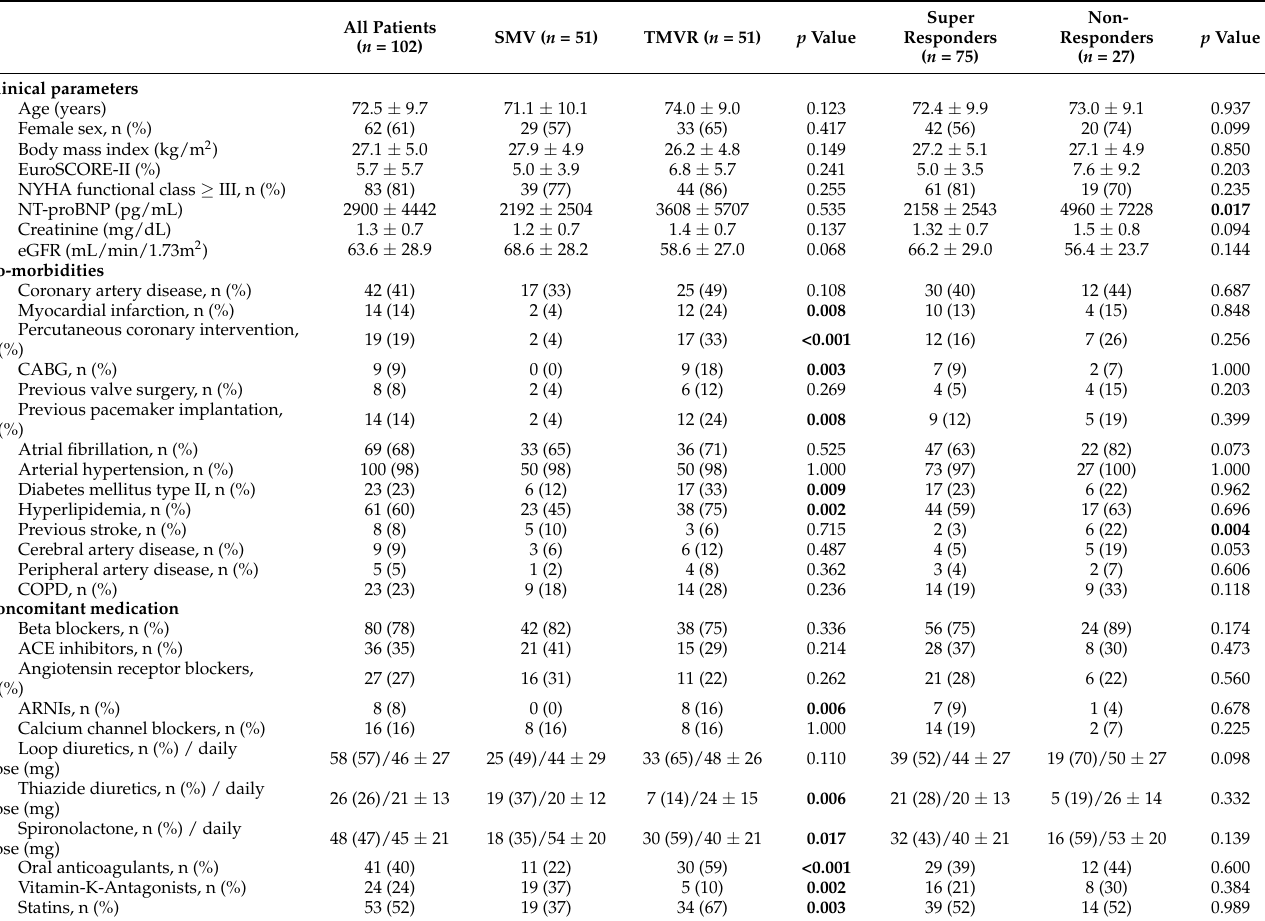
Table 1. Baseline characteristics of the matched study population and stratified for “Super Respon- ders” vs.